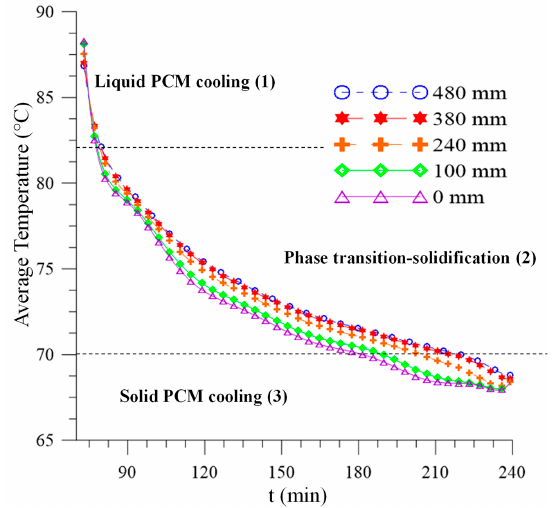
Figure 26. Average temperature during the PCM solidification process.